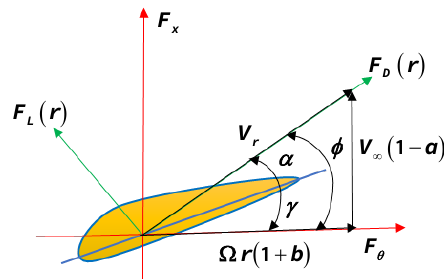
Figure 3. Blade element stress analysis diagram.